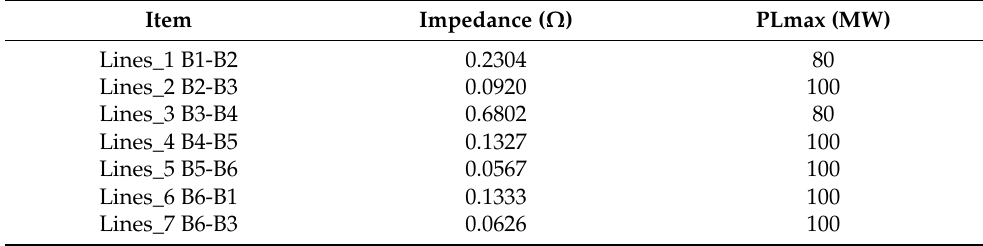
Table A9. Parameters of the 6-bus